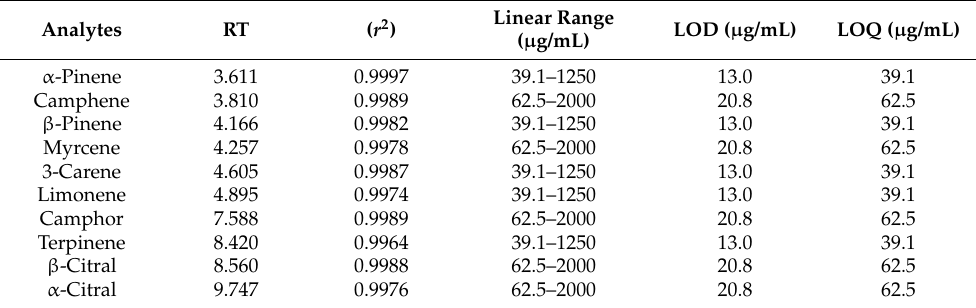
Table 3. Correlation coefficient ( r 2 ), linear range, LOD, and LOQ of 10 monoterpenoids in the anti-cellulite emgel analyzed by